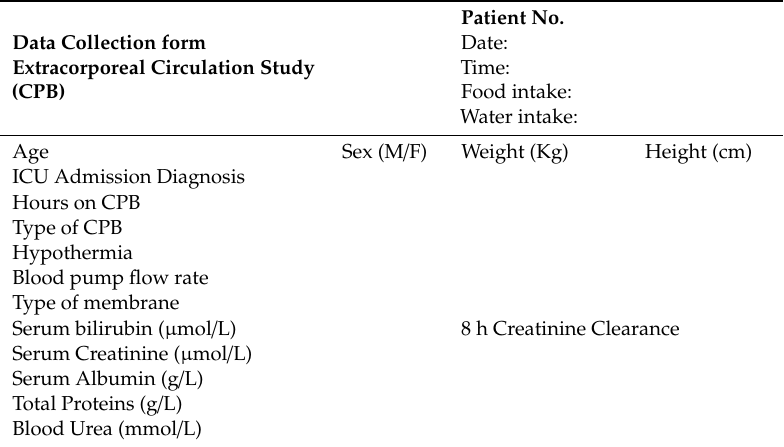
Table 3. Demographic and clinical data collection form for patients on